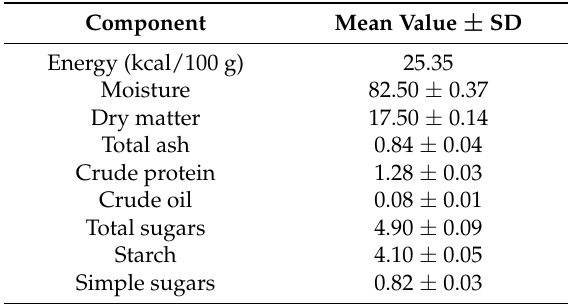
Table 1. Nutritional composition (g/100 g edible part) of pumpkin ( C. maxima , var. Berrettina) (mean value ± standard deviation (SD), n =